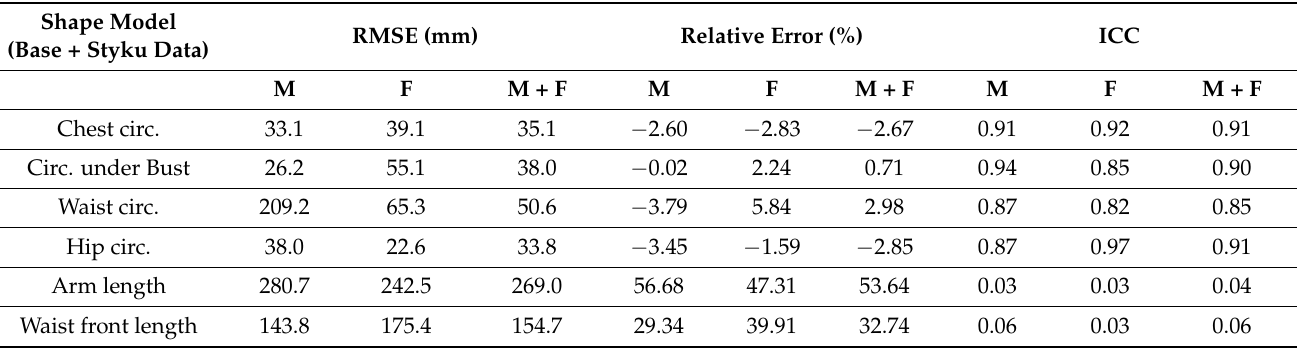
Table 4. Overview of results on the shape model prediction based on the base parameters with additional Styku